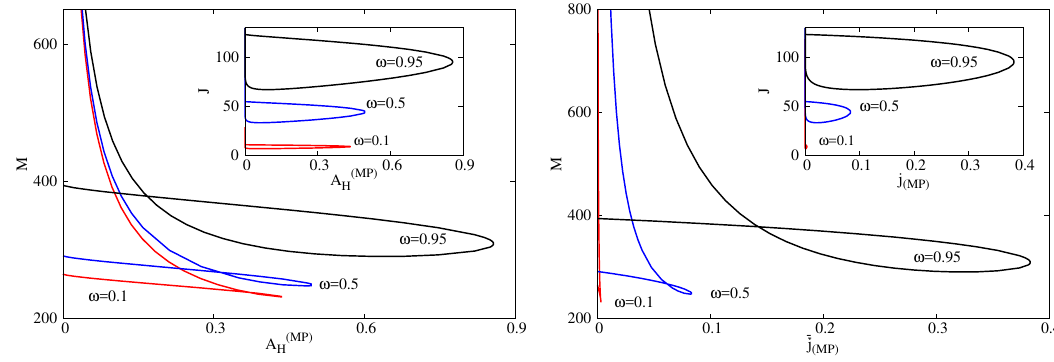
Figure 9 . The mass and angular momentum of Skyrme test (cid:12)eld solutions on a MP background are shown as a function of horizon area and of the reduced MP angular